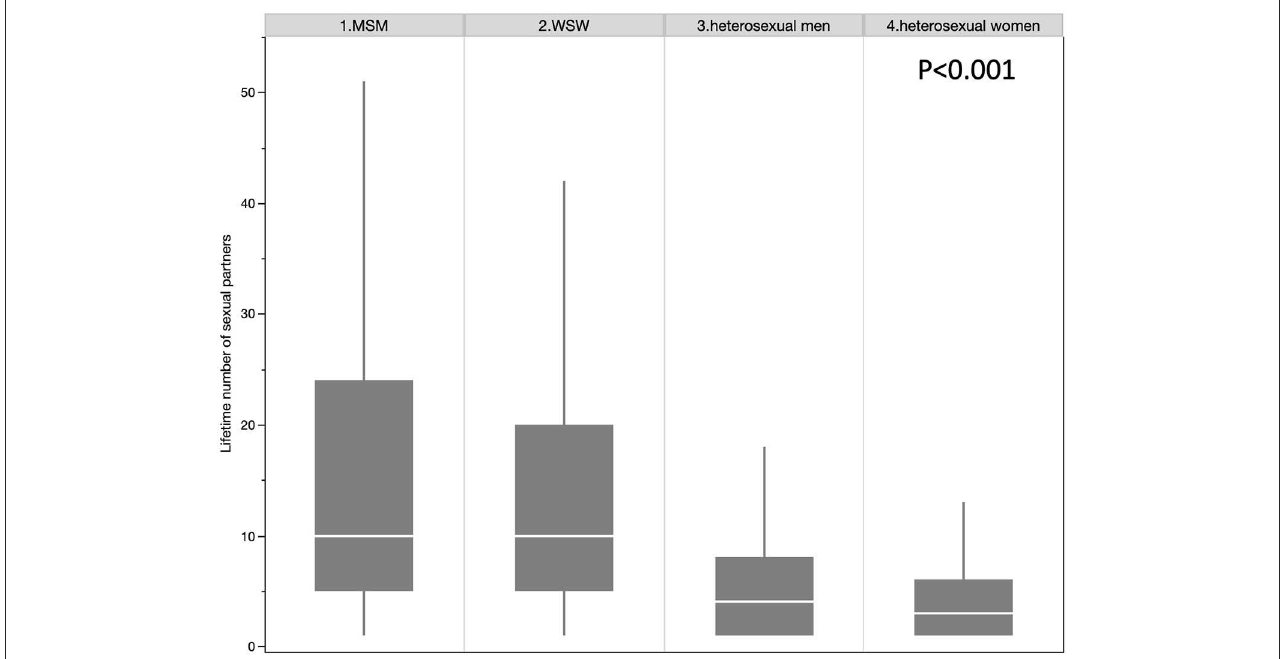
FIGURE2 Lifetime number of sexual partners between the four groups.